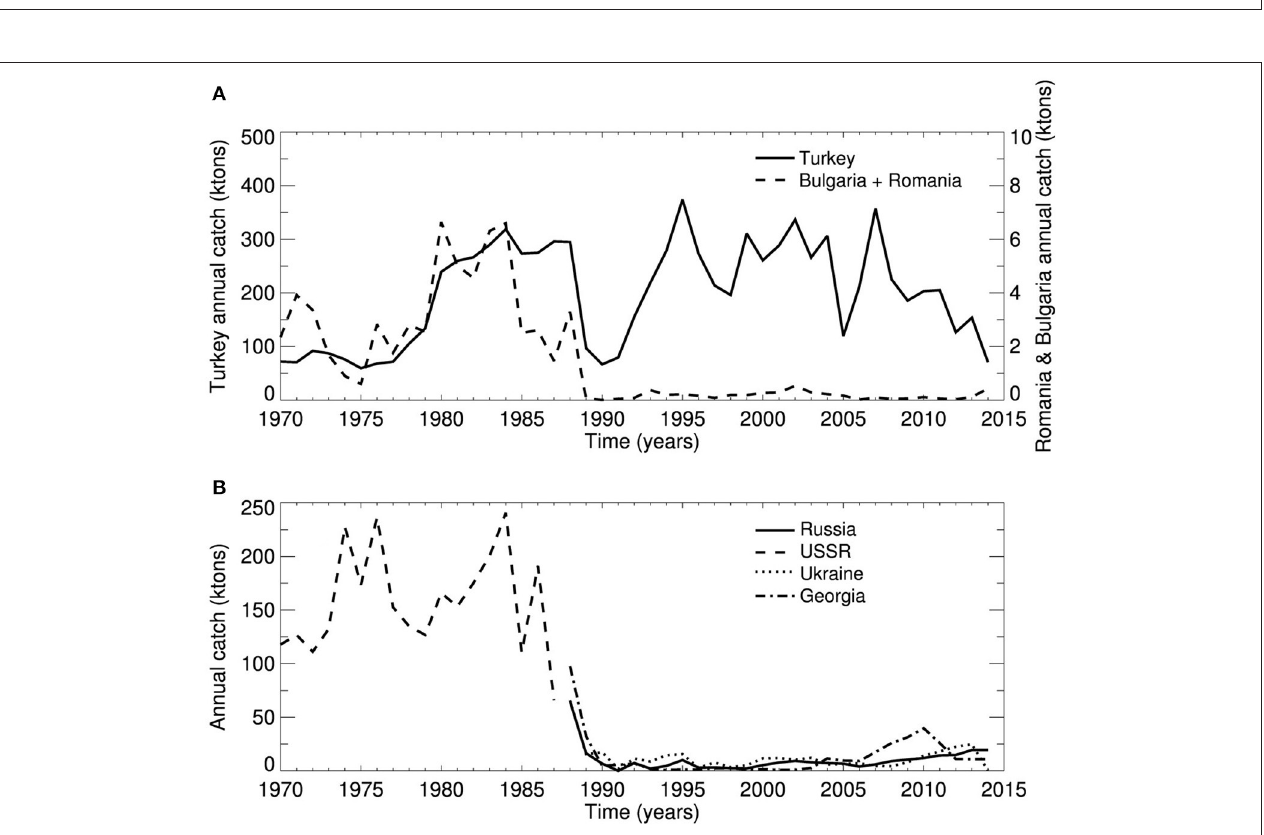
FIGURE 2 | Total annual anchovy landings (ktons) of present and former Black Sea riparian countries from 1970 to 2014 (FAO, 2014). (A) Turkey and Bulgaria-Romania combined and (B) Russia, former USSR, Ukraine and Georgia.